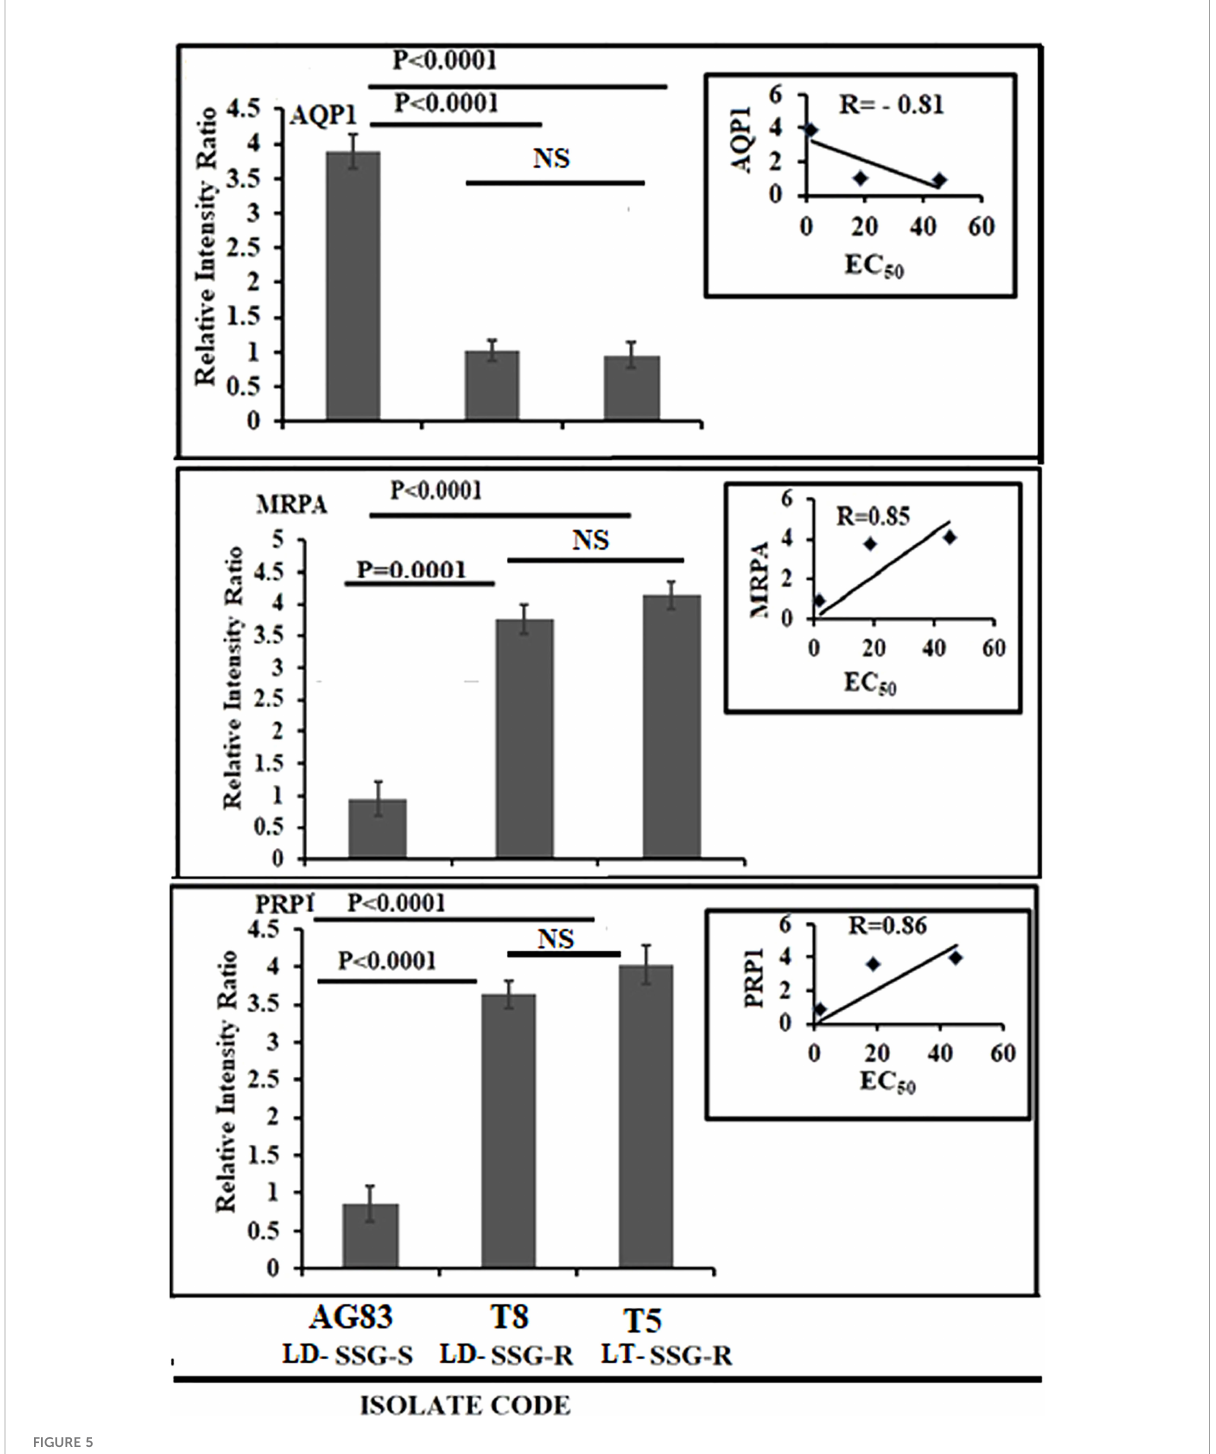
FIGURE 5 Graphical representation of the densitometric data of sodium stibogluconate (SSG)-transporting enzyme and ABC transporter. The expression level of AQP1 was expressed as a ratio of AQP1 mRNA level to GAPDH mRNA level. Data were expressed as the mean ± SD of three independent experiments. Each scatter plot in the inset represents the correlation between the EC 50 of the isolates against SSG and the respective gene expression. The expression levels of MRPA and PRP1 were expressed as the ratio of MRPA and PRP1 mRNA levels to GAPDH mRNA level, respectively. Data were expressed as the mean ± SD of three independent experiments. Each scatter plot in the inset represents the correlation between the EC 50 of the isolates against SSG and the respective gene expression. NS, Non-signi fi